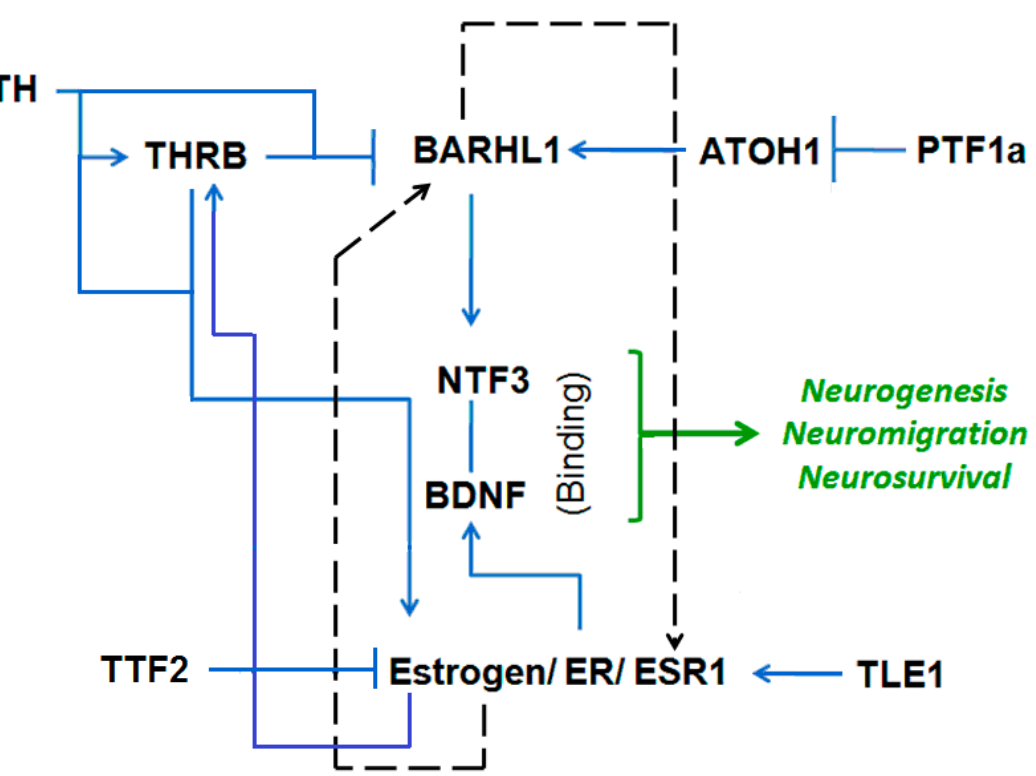
Figure 3. The estrogen-BARHL1 network (see the text for detail). The solid arrow indicates activation/positive regulation; T denotes inhibition; and the dotted arrow designates newly-suggested regulatory networks based on our analysis. TH: thyroid hormone; THRB: thyroid hormone receptor beta; ATOH1: atonal BHLH transcription factor 1; PTF1a: pancreas specific transcription factor 1a; NTF3: neurotrophin 3; BDNF: brain-derived neurotrophic factor; TTF2: transcription termination factor 2; Estrogen/ER/ESR1: estrogen/estrogen receptor/estrogen receptor 1; TLE1: transducin like enhancer of split 1.